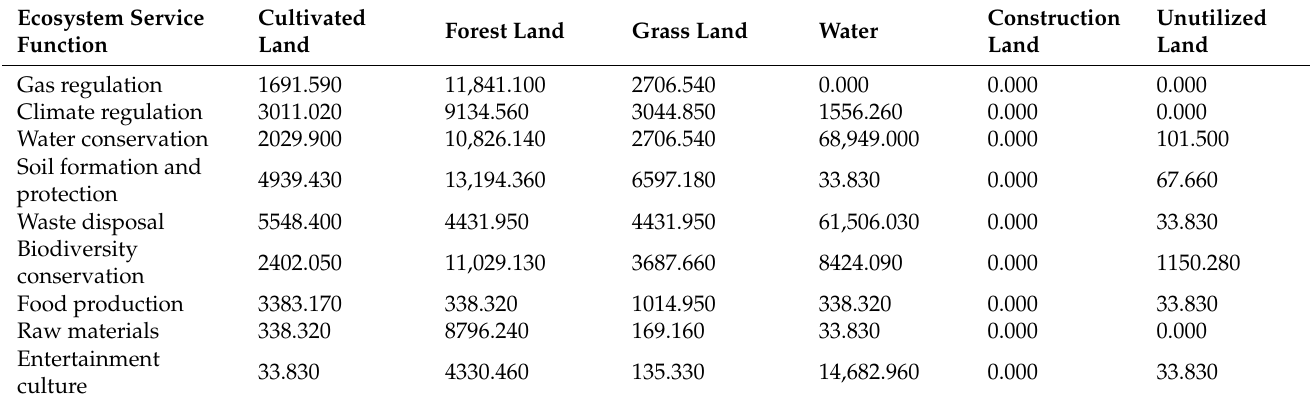
Table 3. Ecosystem service value coefficient of land use types in Nanchang City (Yuan/hm 2 ·